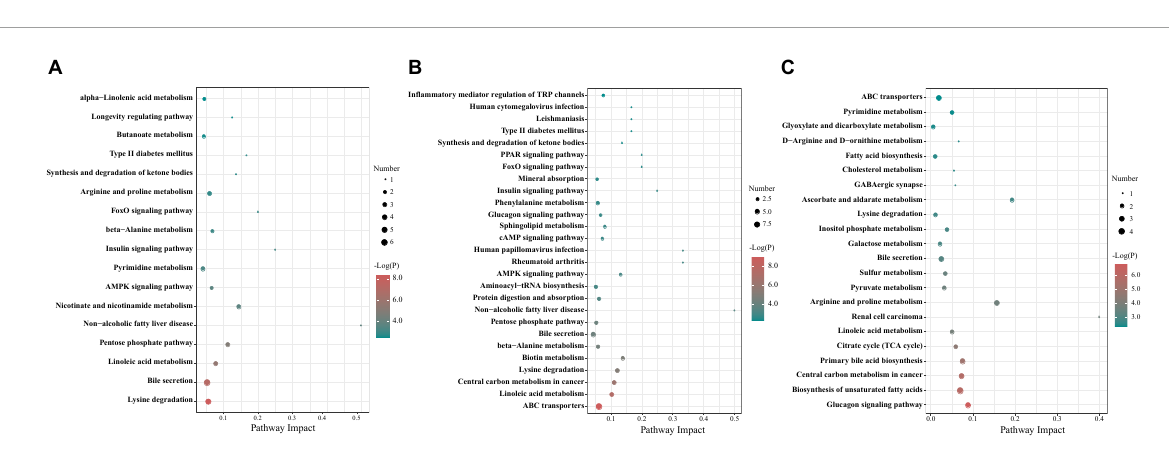
FIGURE10 The bubble chart of enrichment analysis for metabolic pathways in colonic contents of offspring pigs at 65 (A) , 95 (B) , and 125 (C) days of age. The manipulated metabolic pathways are based on the analysis of different metabolites in colonic contents of offspring pigs among different groups following the KEGG pathway database. The metabolome view shows all matched pathways according to the P -values from the pathway enrichment analysis and impact values from the topology analysis. The node colors varied from green to red, indicating that the metabolites have different levels of